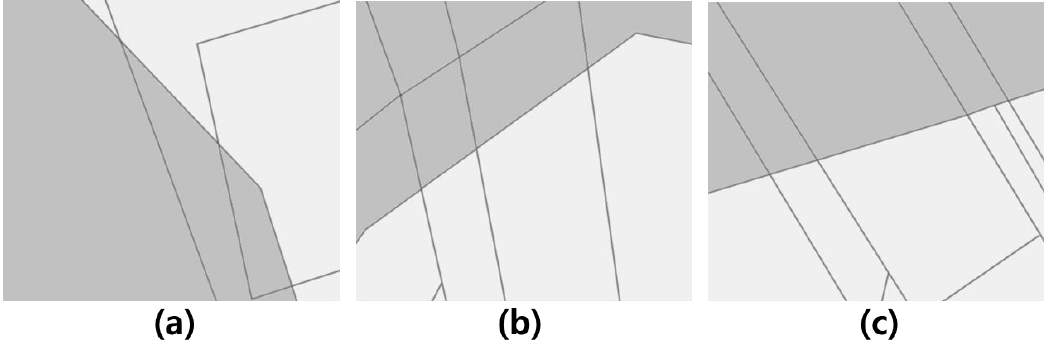
Figure 13. Map alignment to remove gap and overlap of Figure 12; ( a ) alignment result of Figure 12a, ( b ) alignment result of Figure 12b, ( c ) alignment result of Figure